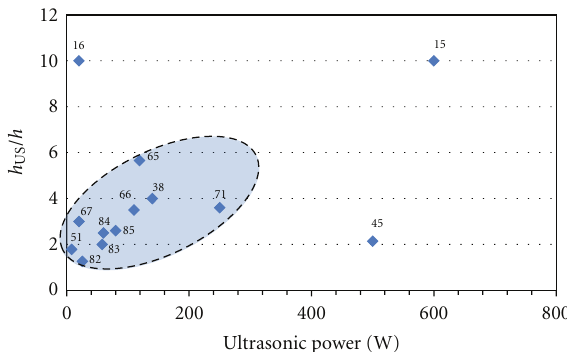
Figure 10: Percentage of studies by subject (total: 62 papers from the tables of this